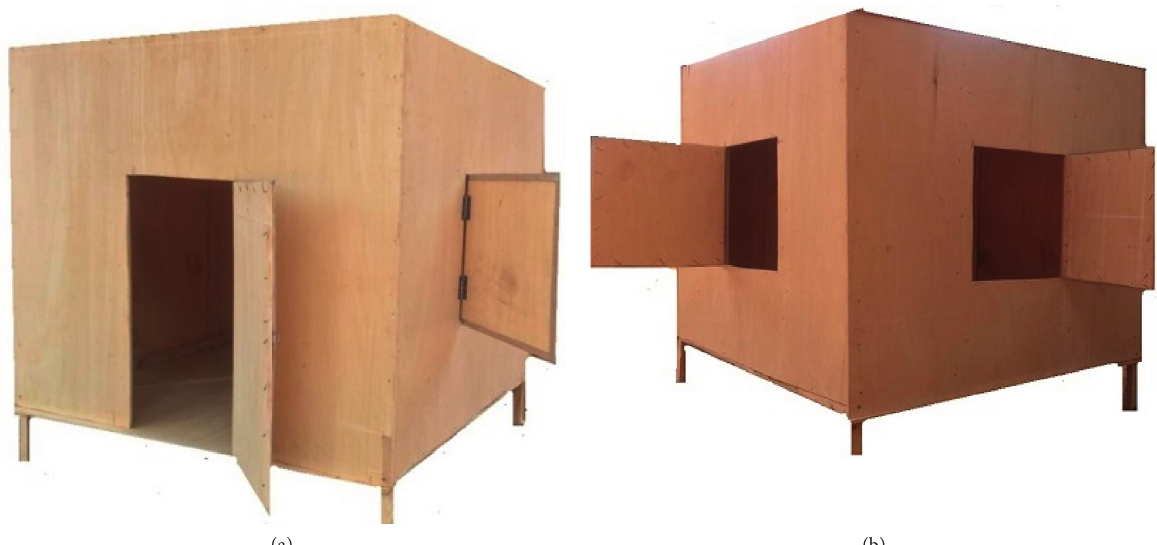
Figure 2: (a) Front view of the experimental domain. (b) Rear view of the experimental domain.